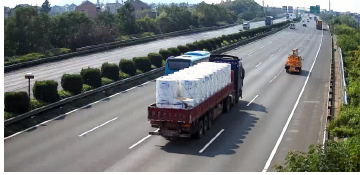
Figure 7. The real situation of Scene 1.